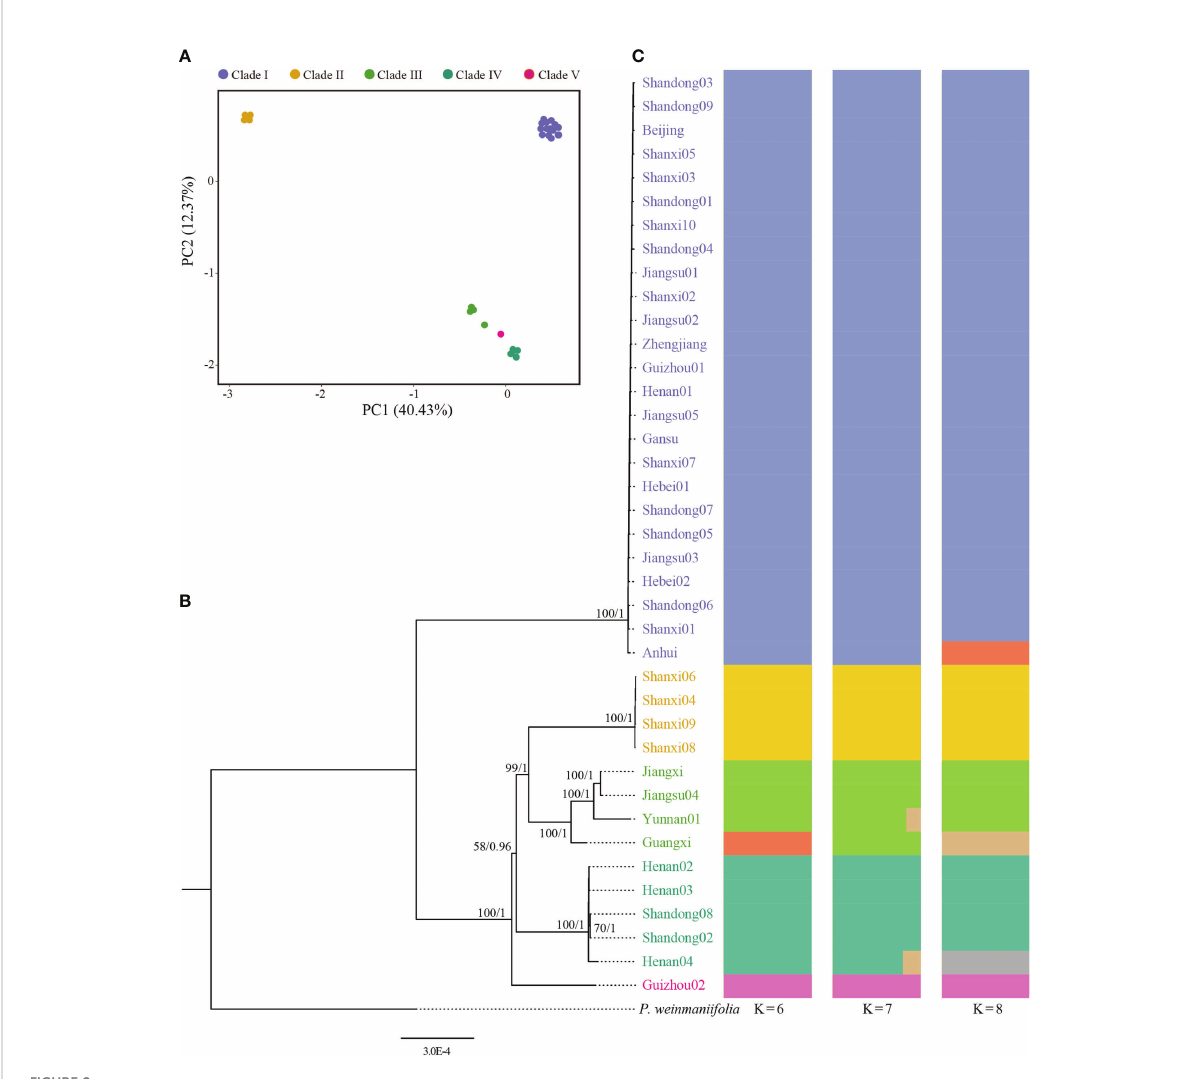
FIGURE 2 Genetic diversity of Pistacia chinensis assessed using complete plastome sequences. (A) Principal component analysis, (B) Phylogenetic tree. ML bootstrap support values/Bayesian posterior probabilities are shown at each node. (C) Population structure analysis with K = 6, 7 and